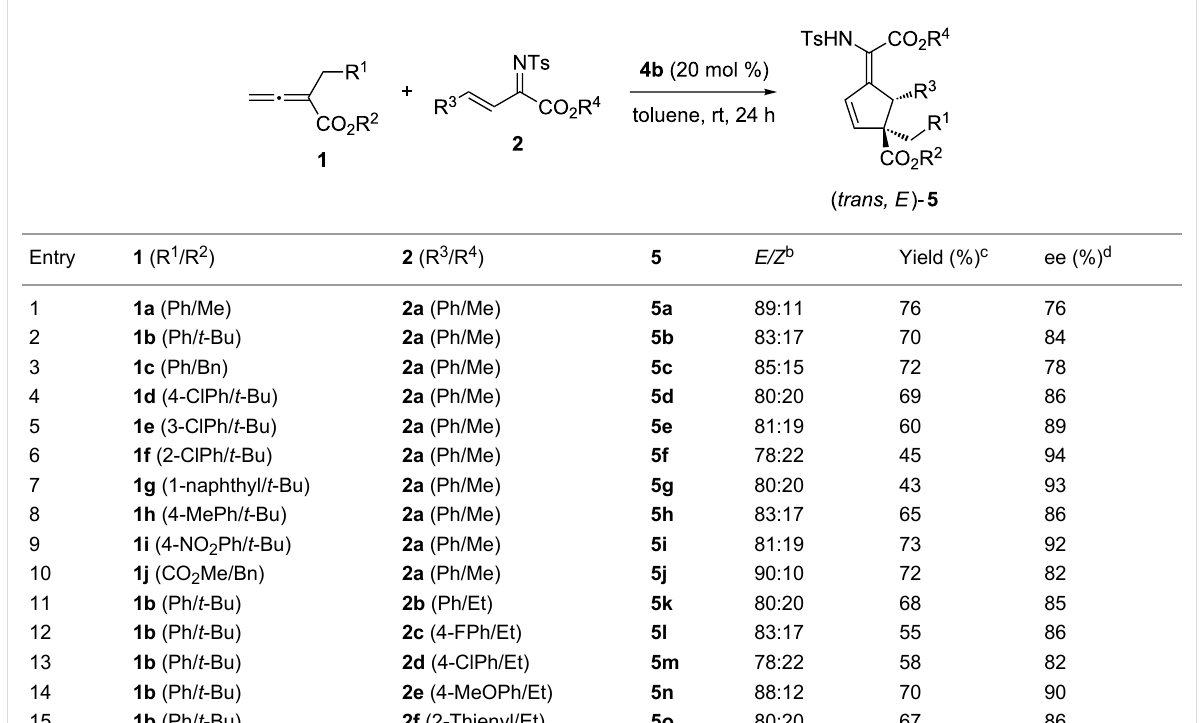
Table 2: Enantioselective [3 + 2] annulation of α -substituted allenoates with β , γ -unsaturated N -sulfonylimines catalyzed by dipeptide catalyst 4b .